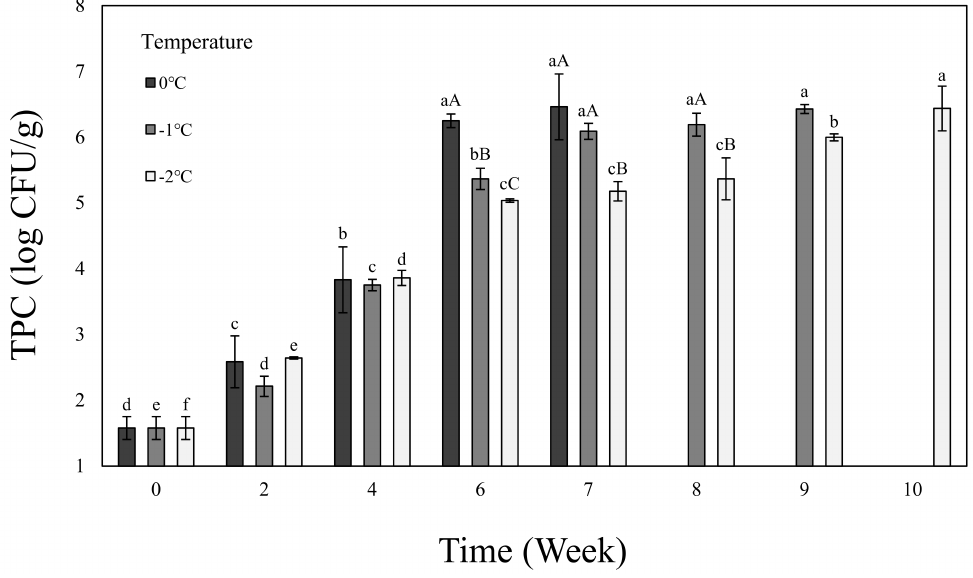
Figure 1. TPC of dry-aged beef loin on 0, − 1, − 2 ◦ C temperature electric field refrigerate sys- tem. a–f Means in the same temperature with different letters are significantly different ( p < 0.05). A–C Means in the same time with different letters are significantly different ( p < 0.05). Samples were measured until aging stopped as the value of TPC reached 7 log CFU/g.